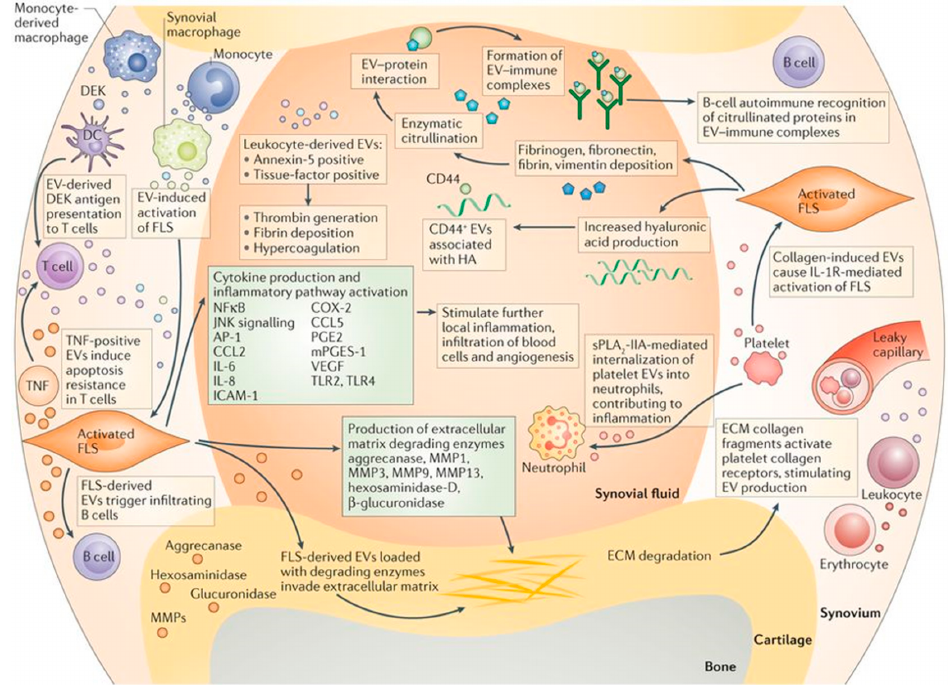
Figure 3. Proposed mechanisms for EV-mediated communication in joint inflammation and disease pathogenesis [2]. EVs are thought to be responsible for intercellular communication among immune cells, fibroblast-like synoviocytes (FLS), chondrocytes and bone cells within a diseased joint environment, leading to chronic inflammation, matrix degradation and irreversible progression of joint degeneration. Reproduced with permission from [2]. Copyright Springer Nature, 2016.